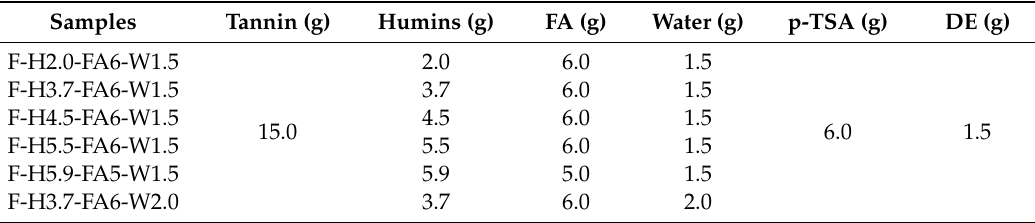
Table 1. The formulation of tannin–humins